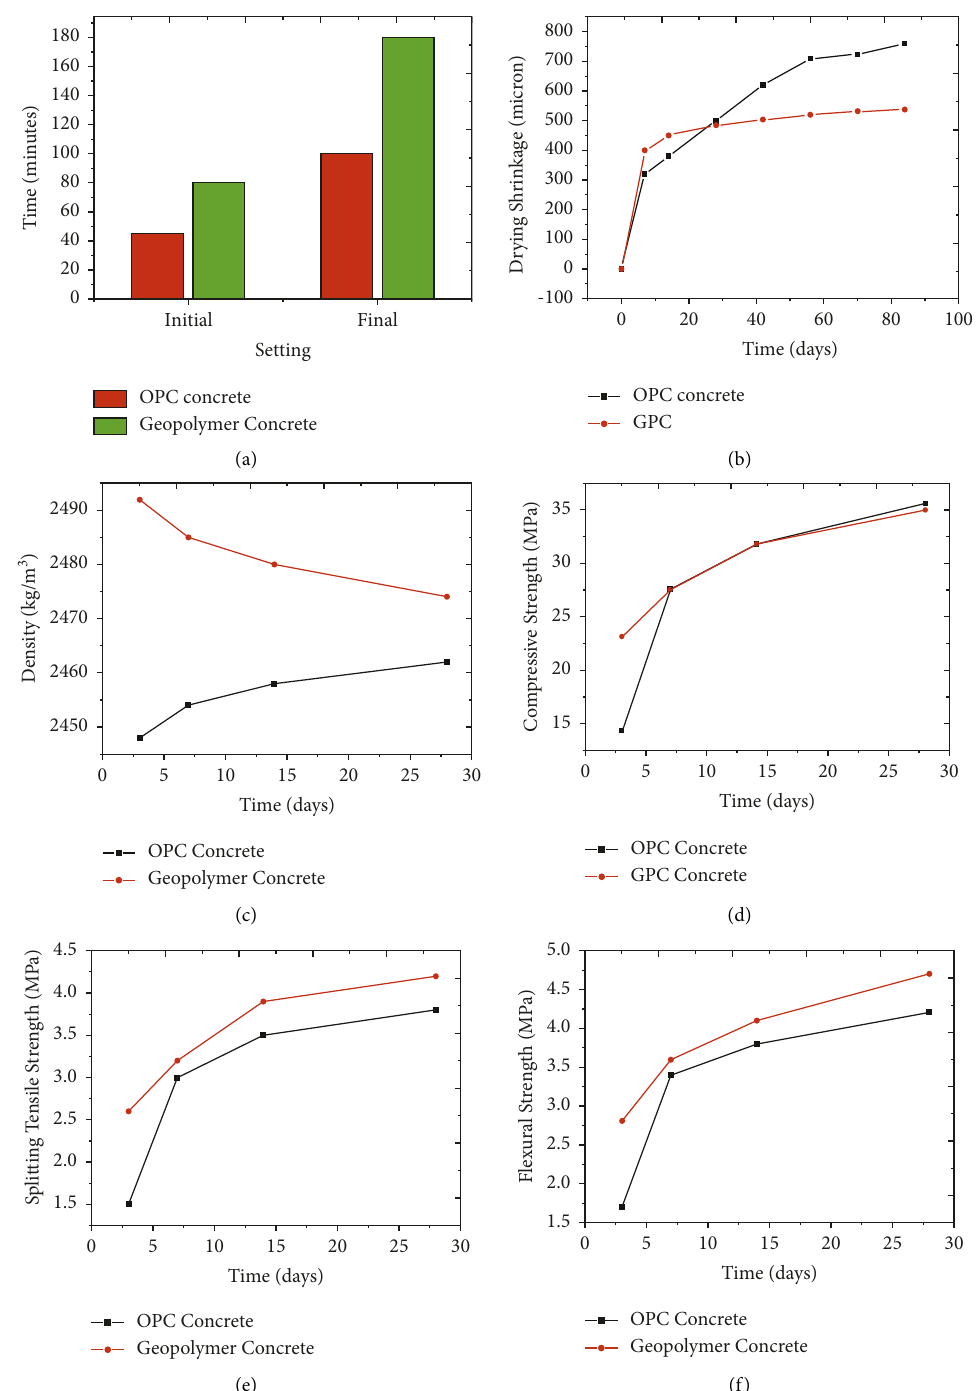
Figure 6: (a) Setting time of concretes; (b) drying shrinkage of the concretes; (c) density variations with time; (d) compressive strength of GPC and OPC concrete; (e) splitting tensile of the GPC and OPC concrete; and (f) flexural strength of GPC and OPC